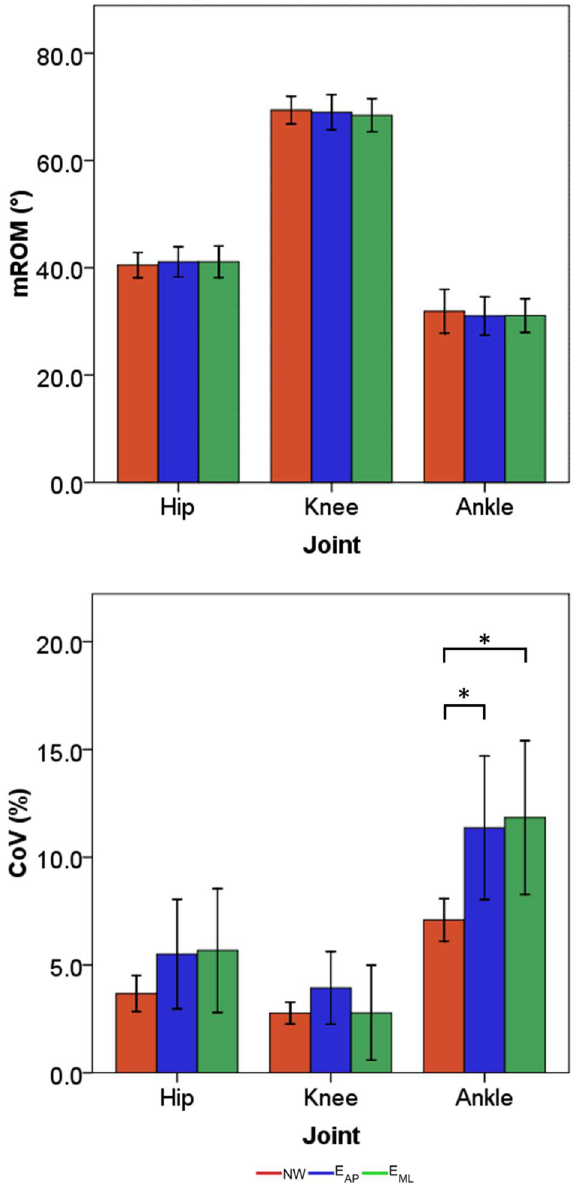
Figure 5. Means and standard deviations of the mROM ( top ) and CoV ( bottom ) for all three motion tasks. Red, blue, and green are used to identify the normal walking, the perturbed locomotion in anterior-posterior direction, and the perturbed locomotion in medio-lateral direction, respectively. * is placed in correspondence to statistical differences among tasks.